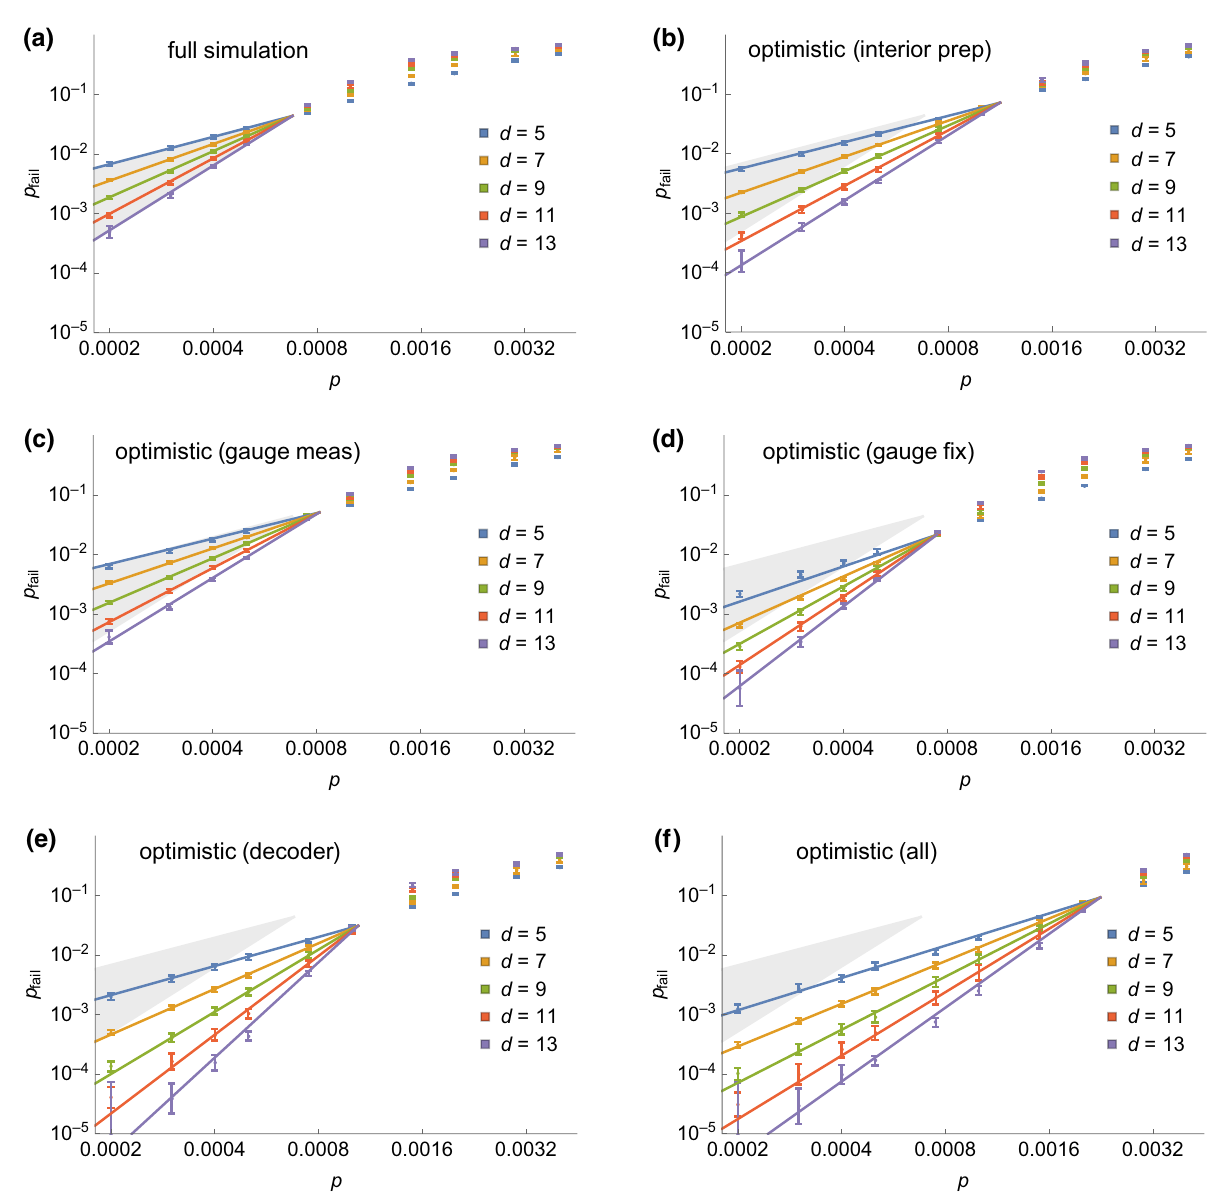
(cid:26) (cid:27) ( Cd + D ) to fit the data up to the crossing. The gray region p / p ∗ CS